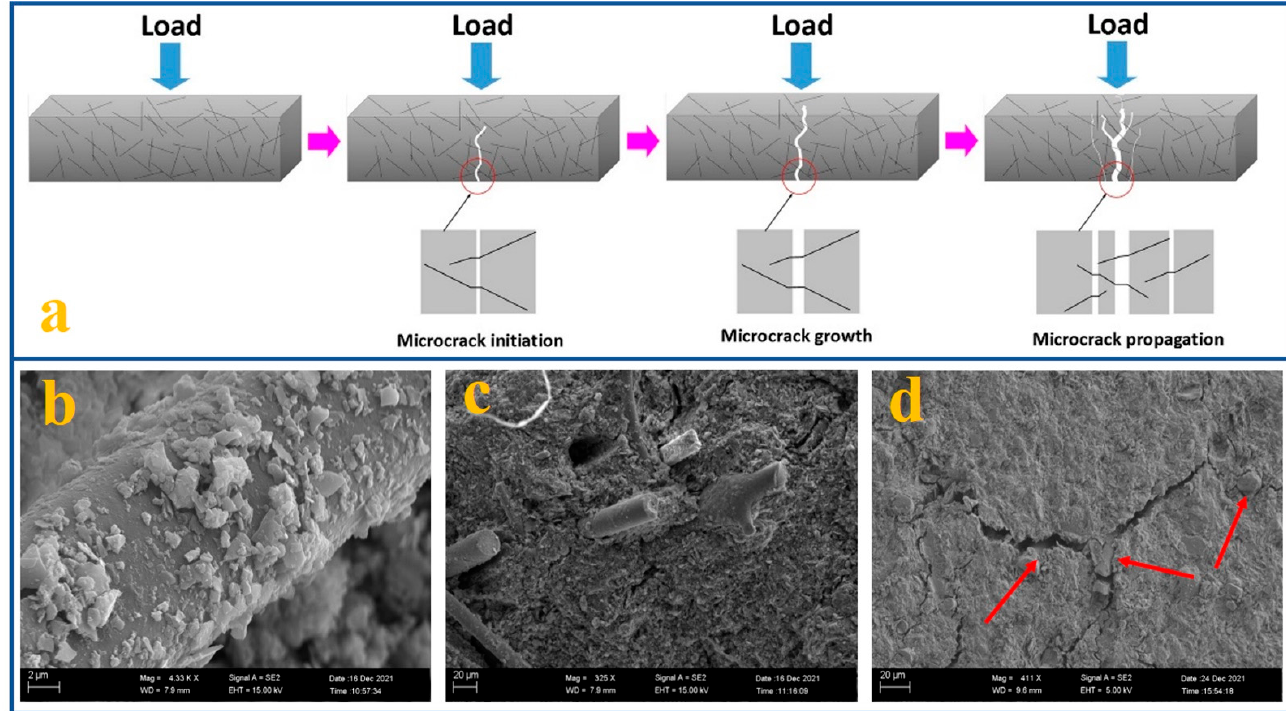
Figure 10. ( a ) Reinforcement mechanism of polyimide fiber-modified ASP geopolymers; SEM images of the interface between the mullite fiber and geopolymer matrix: ( b ) geopolymer grains on the mullite fibers, ( c ) fiber pullout, and ( d ) crack deflection [66,83].